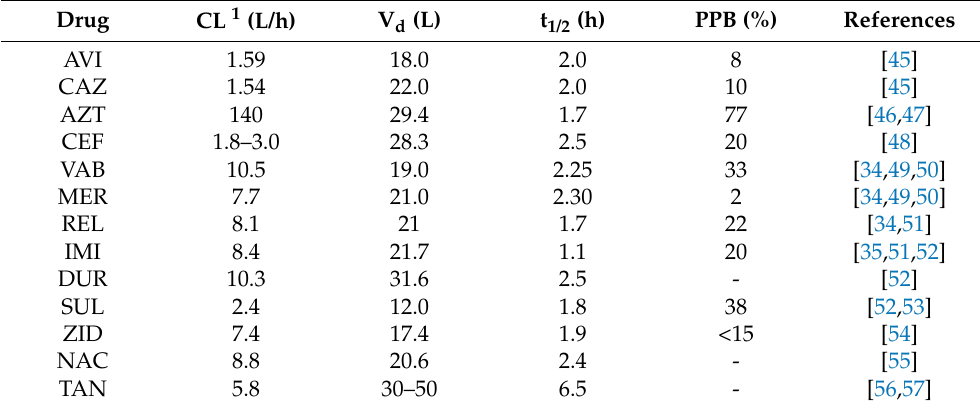
Table 2. Main pharmacokinetic characteristics of BLIs and their beta-lactam companion for compari-